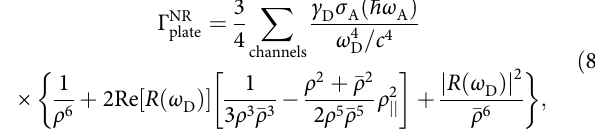
Fig. 5 we plot the separation-dependence of the rate (10) in vacuum and in helium, both with and without local- fi eld corrections. The rates (5) and (7) emerge from Eq. (10) in its vacuum ( n → 1, κ → 0), and non-retarded ρω